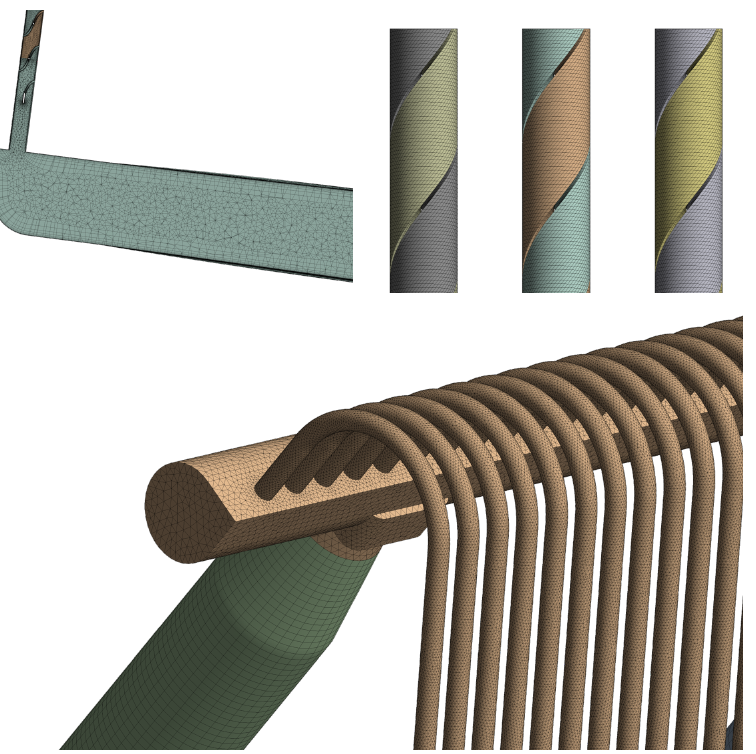
Figure 9. Finest mesh adopted for OVT mock-up cooling circuit CFD